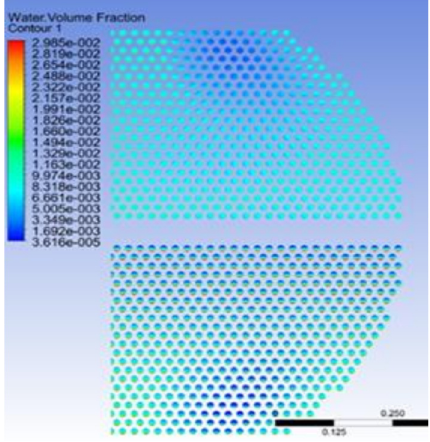
Figure 26. Distribution of the water